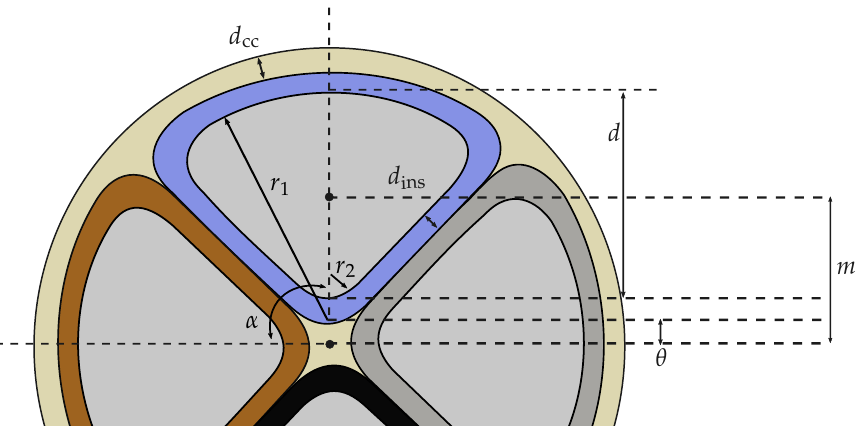
Figure 10. Sectional view and parameter definition of a four-core underground cable based on Reference